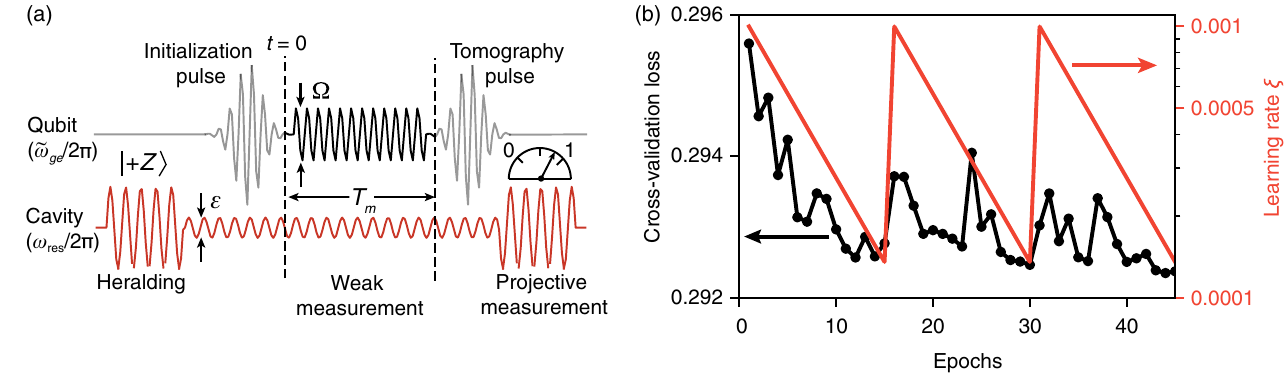
FIG. 7. (a) Experimental pulse sequence for training data acquisition. Time axis is not to scale. (b) Cost function (black, left-hand axis) computed on the cross-validation dataset during a typical training session. Temporary increases in the cost function are expected as the learning rate (red, right-hand axis) increases